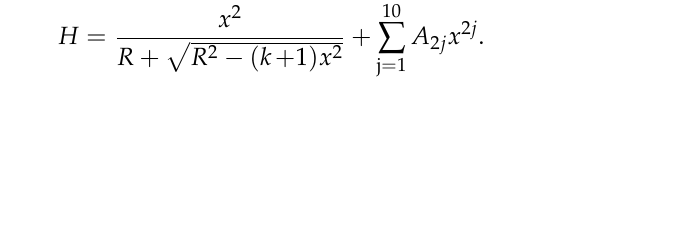
Figure 5. Simulation diagram of the superposition of the discrete TIF and screw feed polishing trajectory: ( a ) Equal pitch TIF; ( b ) Equal pitch polishing trajectory (2D); ( c ) Equal pitch polishing trajectory (3D); ( d ) Variable pitch TIF; ( e ) Variable pitch polishing trajectory (2D); ( f ) Variable pitch polishing trajectory (3D).